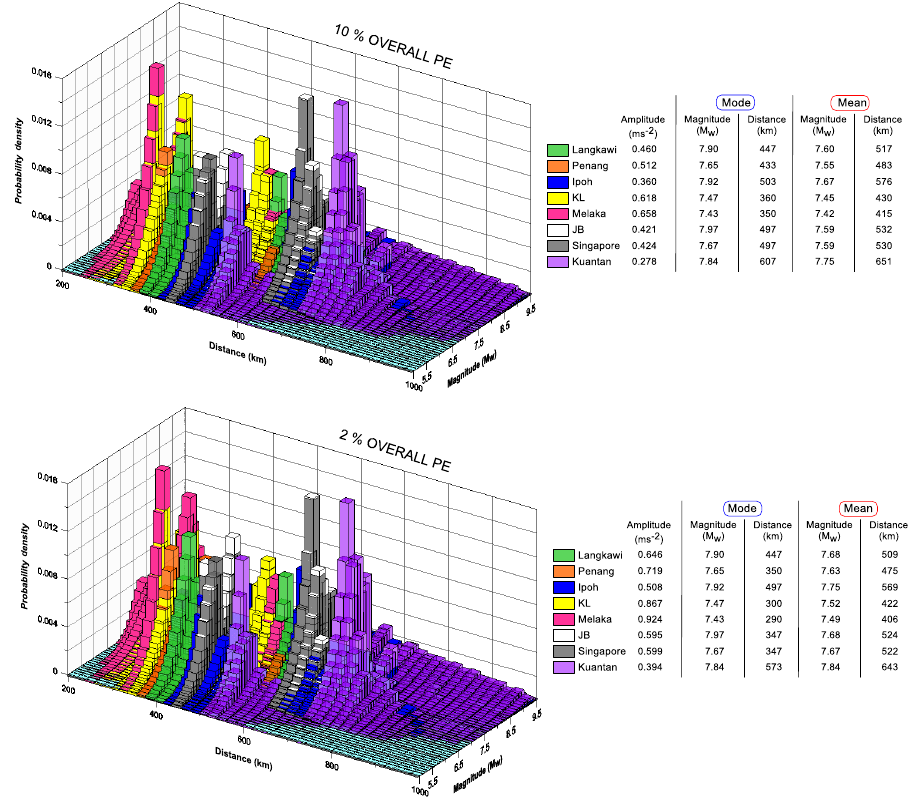
Figure 14. Disaggregation plots showing PGA relative contribution from the Sumatran region for Peninsular Malaysia and Singapore as a function of distance and magnitude at various major cities at 10% and 2% PE,